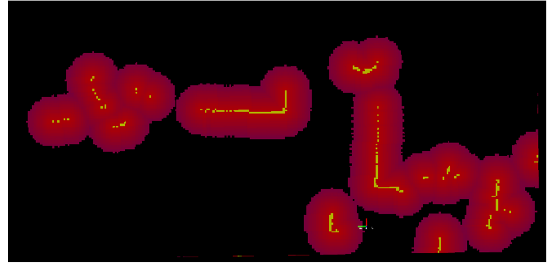
Fig. 3 Likelihood field